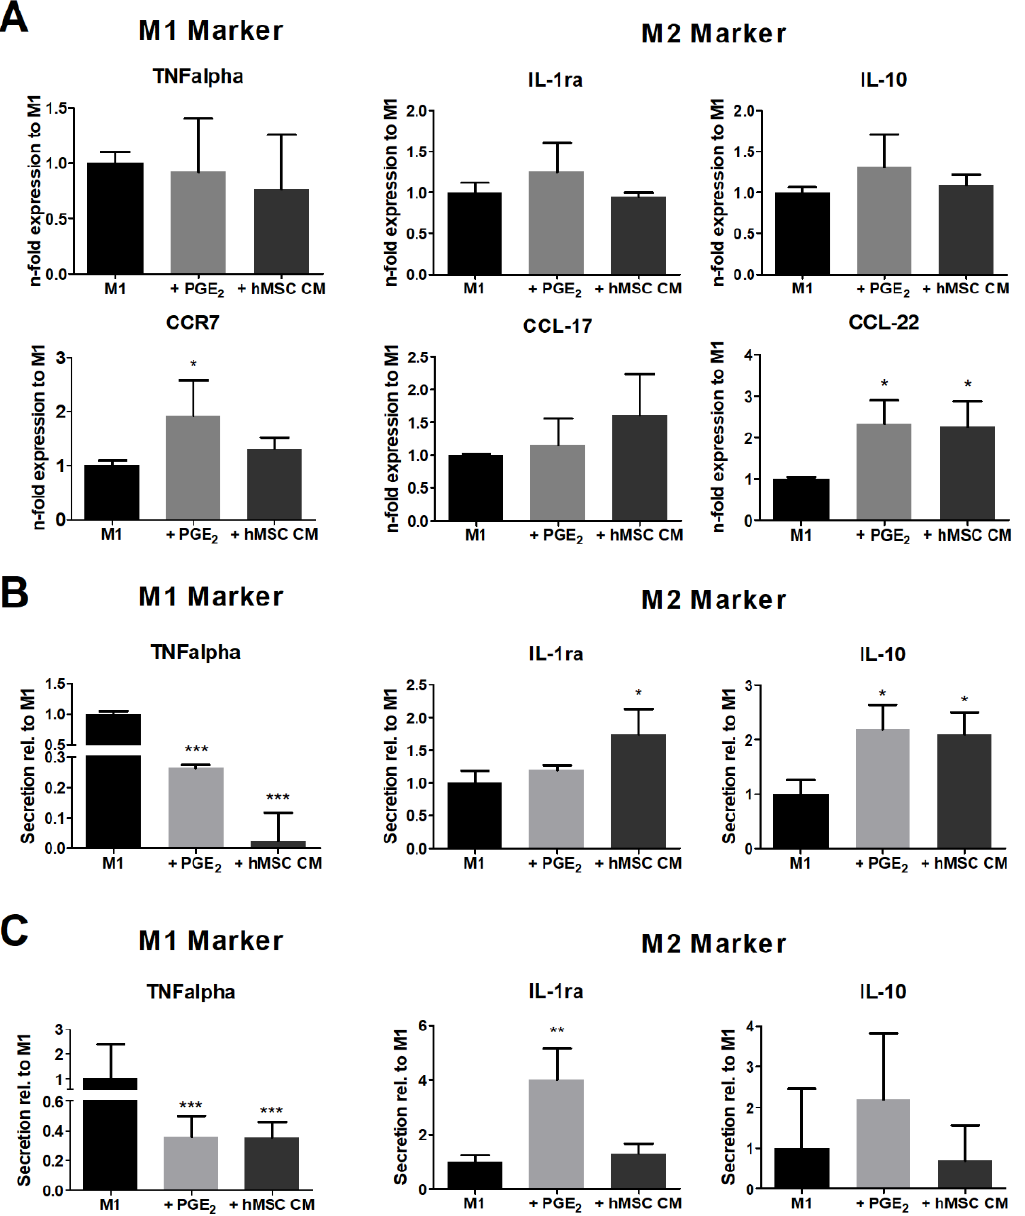
Figure 2. PGE 2 and conditioned medium of hMSCs modulate the M1 polarization of macrophages. Macrophages were polarized to M1 without (M1, black bars) or with 5 ng/mL PGE 2 (+PGE 2 , light grey bars) or the conditioned medium of M1-primed hMSCs (+hMSC CM, dark grey bars). ( A ) THP-1 gene expression upon M1 polarization after 24 h. Displayed are proinflammatory genes, TNFalpha and CCR7, and anti-inflammatory genes, CCL-17, CCL-22, IL-1ra, and IL-10. ( B ) Cytokine secretion of THP-1 macrophages upon M1 polarization after 24 h. Displayed are the proinflammatory cytokines, TNFalpha, and the anti-inflammatory cytokines IL-1ra and IL-10. ( C ) Cytokine secretion of primary macrophages (hMDMs) upon M1 polarization after 24 h. Statistical significance was determined against M1 using one-way ANOVA and Dunnett’s post hoc test. * = p < 0.05; ** = p < 0.01; and *** = p < 0.001. n = 3.